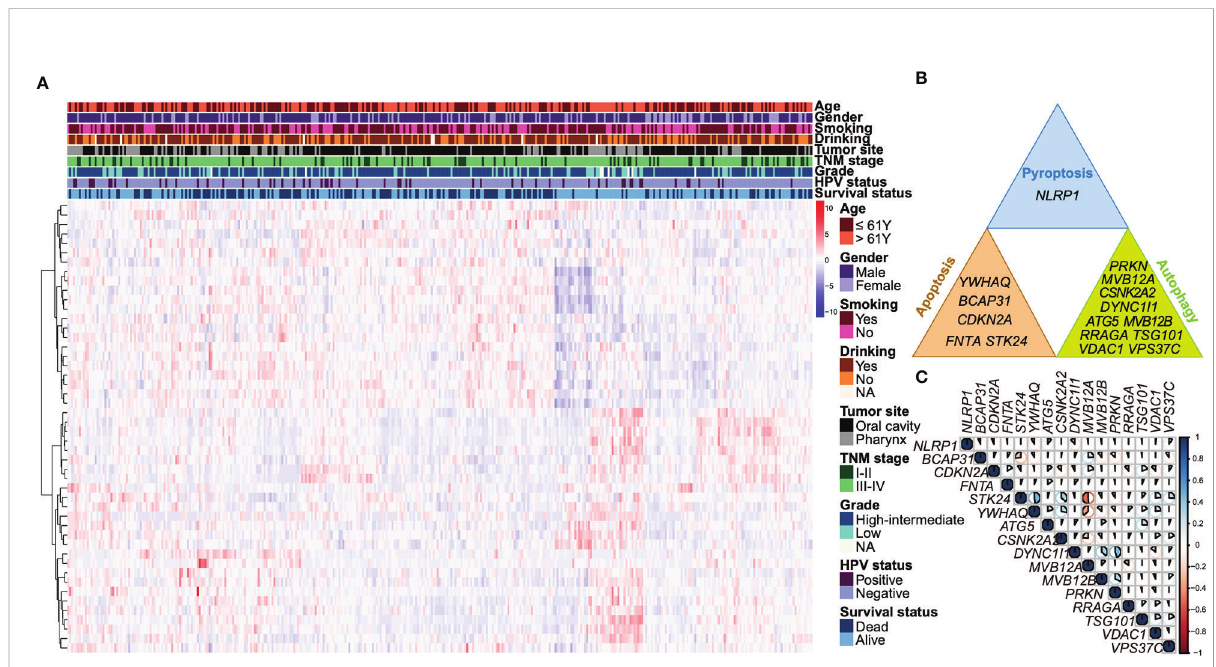
FIGURE 1 Identi fi cation of overall survival associated autophagy, apoptosis and pyroptosis-related genes. (A) A heatmap illustrates a unsupervised hierarchical clustering of the expressions of the 48 overall survival associated genes identi fi ed by univariate Cox regression based on the Ward D2 method. The data was scaled by row using Z-score normalization. The clinicopathologic characteristics, including age, gender, smoking status, drinking status, tumor site, TNM stage, tumor grade, HPV status, as well as survival status are annotated. (B) The 16 overall survival associated autophagy, apoptosis and pyroptosis-related genes are shown respectively. (C) A correlation heatmap shows the coef fi cients of 16 autophagy, apoptosis and pyroptosis-related genes. The area of the pie represents the absolute value of the coef fi cients. Blue indicates a positive correlation and red is a negative